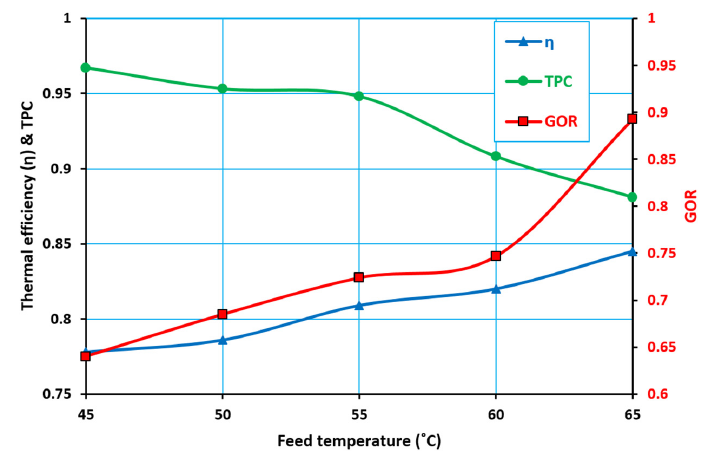
Figure 16. Thermal e ffi ciency, the gain output ration (GOR) and the thermal polarization coe ffi cient (TPC) of the DCMD system at various feed temperatures, 15 g / L NaCl and a feed flow rate of 1.07 L /